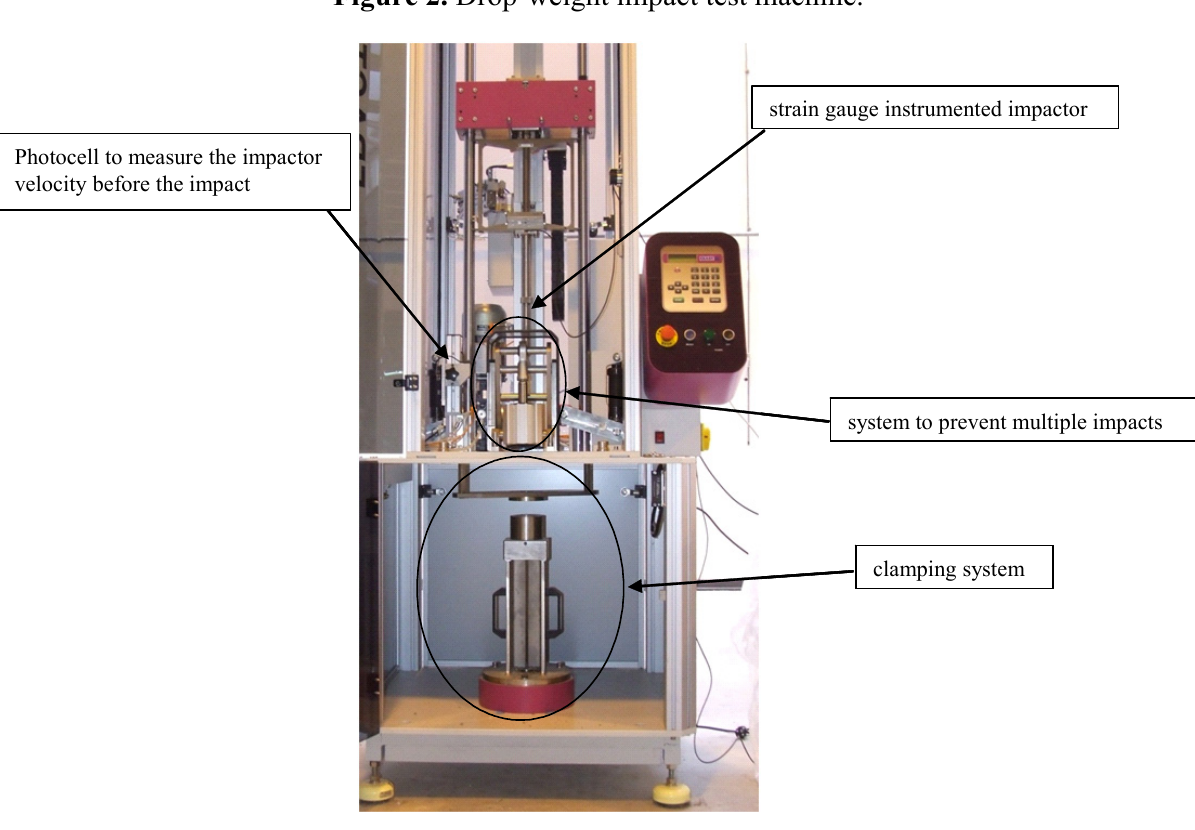
Figure 2. Drop-weight impact test